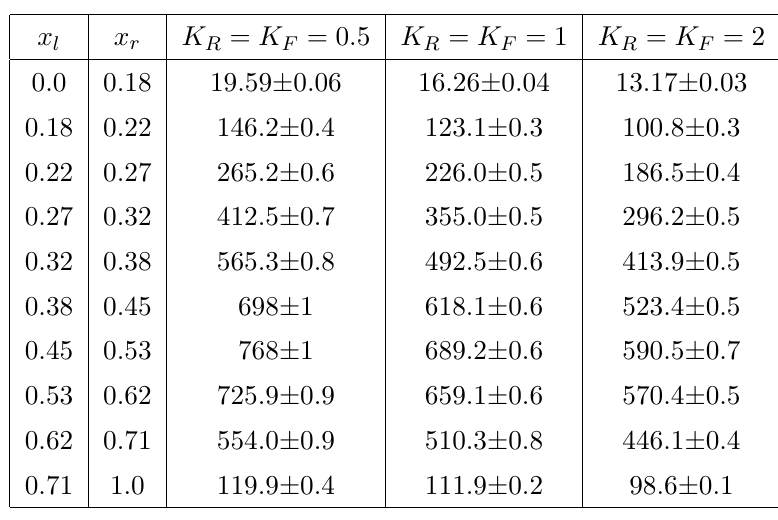
Table 6 . Same as table 3, but for µ 0 = m B